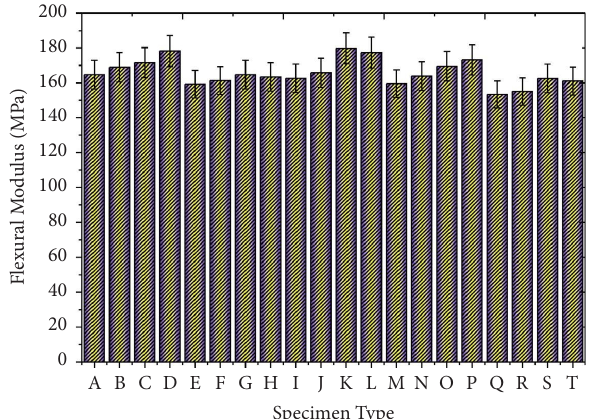
Figure 7: Flexural modulus of biosynthesised Al epoxy hybrid composites.